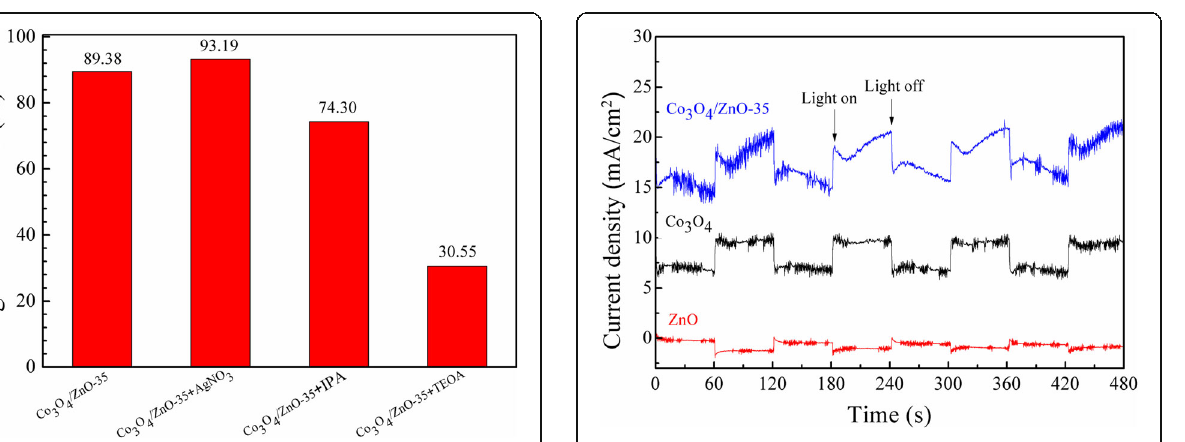
Fig. 14 The photocurrent transient responses profiles for the synthesized Co 3 O 4 , ZnO and Co 3 O 4 /ZnO-35